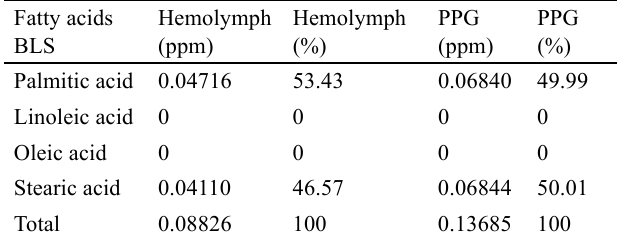
Table 1 . Fatty acid quantification in the hemolymph and postpharyngeal glands (PPG) of Atta sexdens rubropilosa workers before lipid supplementation